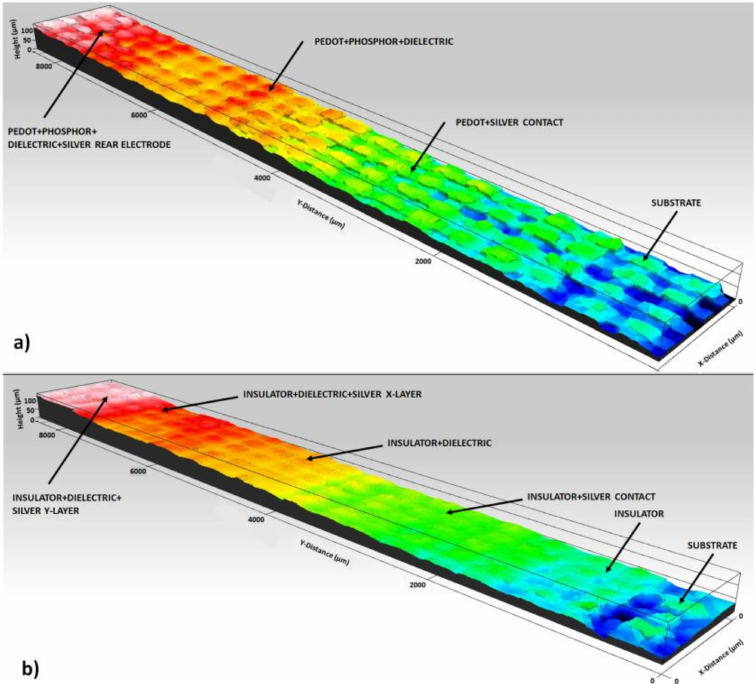
Figure 4. Electroluminescent Display layers profilometry ( a ). 2D Touchpad layers profilometry, in this case fabrics A and B are studied in order to value the insulator layer ( b